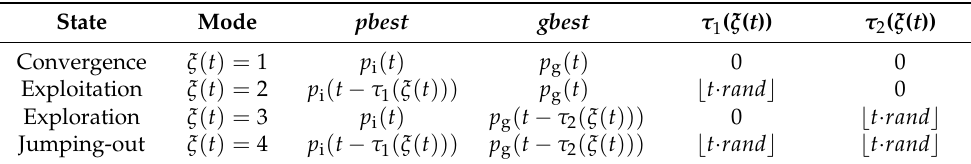
Table 2. Strategies for selecting delayed information and